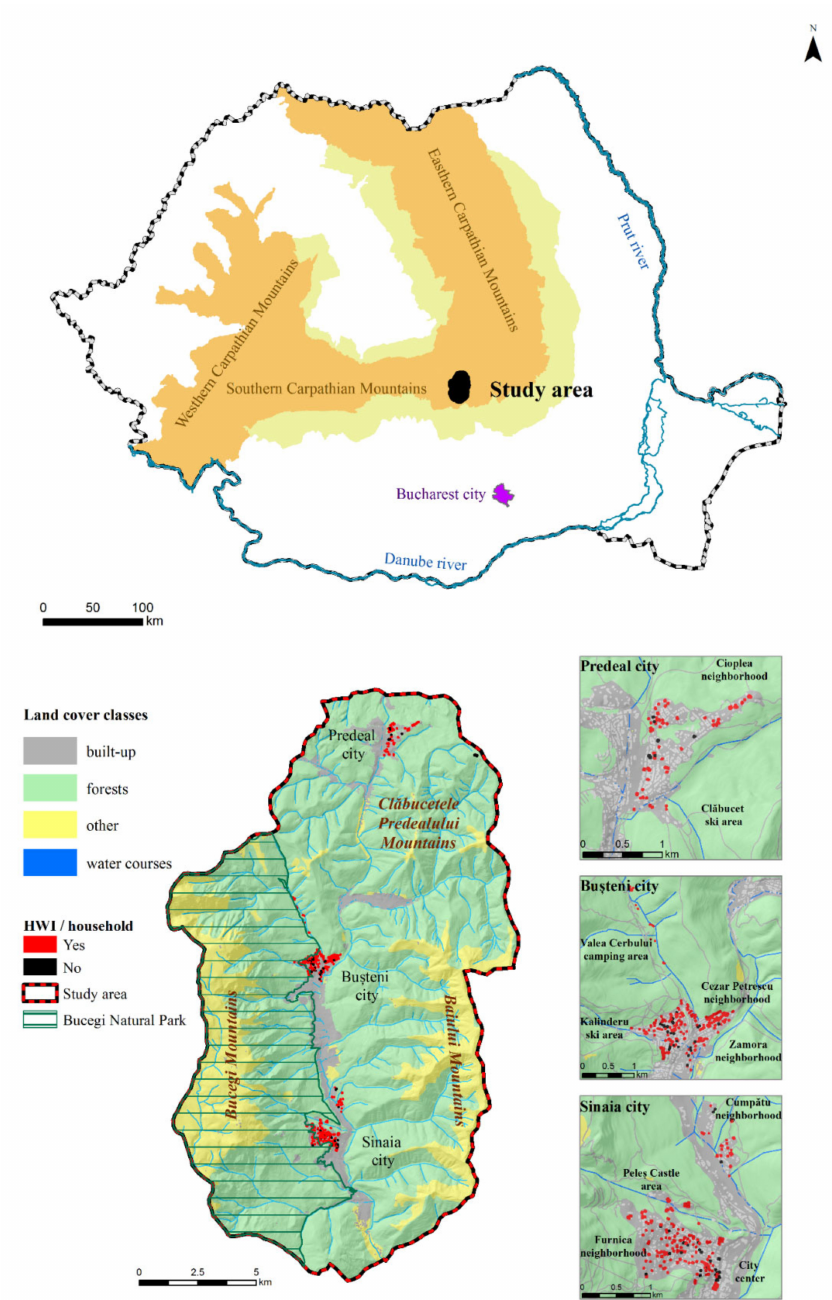
Figure 2. Location of the study area and sampling sites. The valley lies in the Alpine biogeographical region. Mixed forests composed by European beech ( Fagus sylvatica ), European silver fir ( Albies alba ), European spruce ( Picea abies ), European larch ( Larix decidua ), and common yew ( Taxus baccata ) dominate the landscape, with several large patches of intact old-growth forests still being preserved in areas where forest exploitation and management is difficult [26]. These habitats host one of the largest populations of large carnivores within Europe, the main species being the intensively studied brown bear, grey wolf, and Eurasian lynx ( Lynx lynx ). Other rare and protected wildlife species include the European wild cat ( Felis silvestris ), black goat ( Rupicapra rupicapra ) and several bird species. The Eurasian capercaillie ( Tetrao urogallus ) and common raven ( Corvus corax ) are the most representative. The area hosts a dense concentration of protected areas, such as the Bucegi Natural Park (designated in